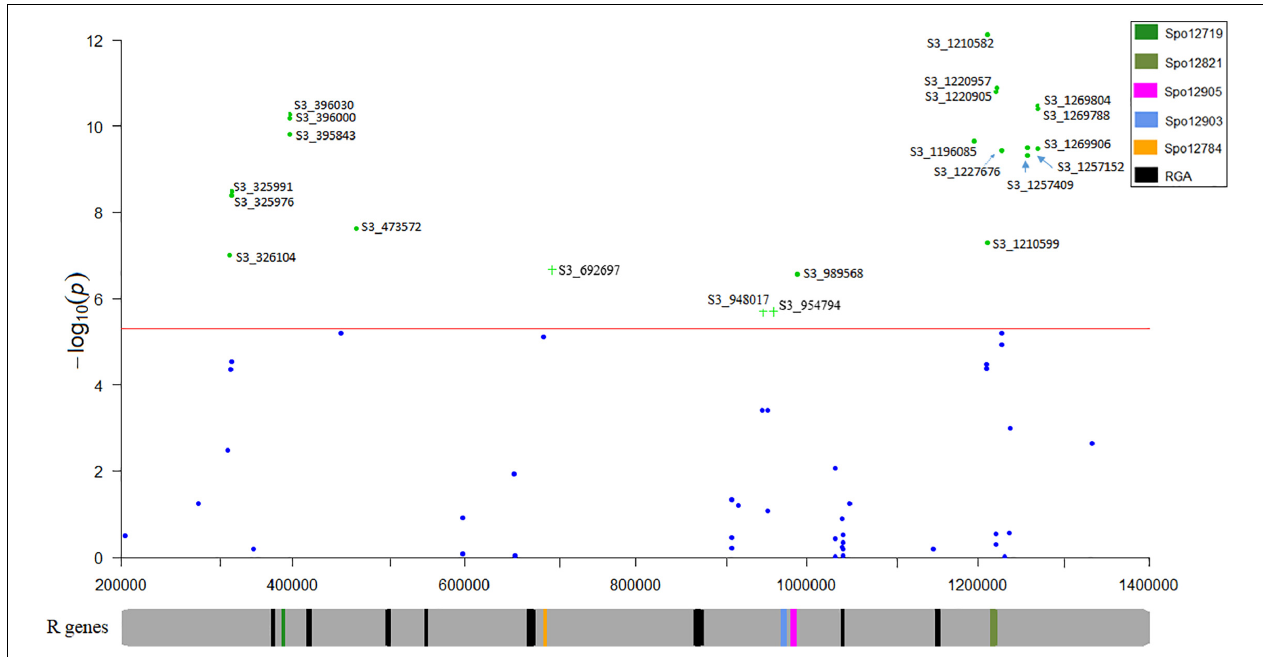
FIGURE 7 | Regional association plot of the race 13 of P. effusa resistance in spinach. The horizontal and vertical axis represents the genomic position of the SNP and association power for each SNP with the trait expressed as –log 10 ( P -value). The red line shows the Bonferroni-corrected genome wide threshold. The SNPs are named for chromosome and position. S3_325976 means SNP loci are located on chromosome 3 and positioned at 325976 bp. Plus (+) signs indicate SNP associations obtained from the second association panel composed of lines generated from a cross of Swan and Whale. Chromosomal location of the disease resistance candidate genes predicted to associate from this study, and other resistance genes between 0.30 and 1.30 Mb of spinach chromosome 3 were